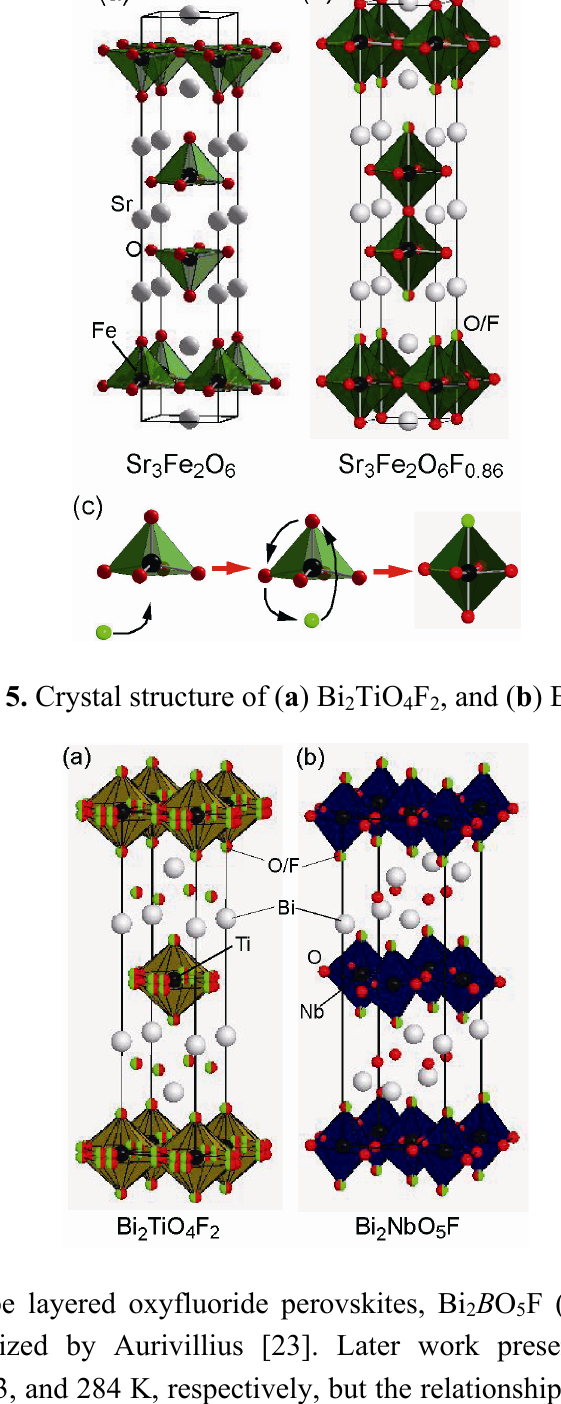
Figure 5. Crystal structure of ( a ) Bi